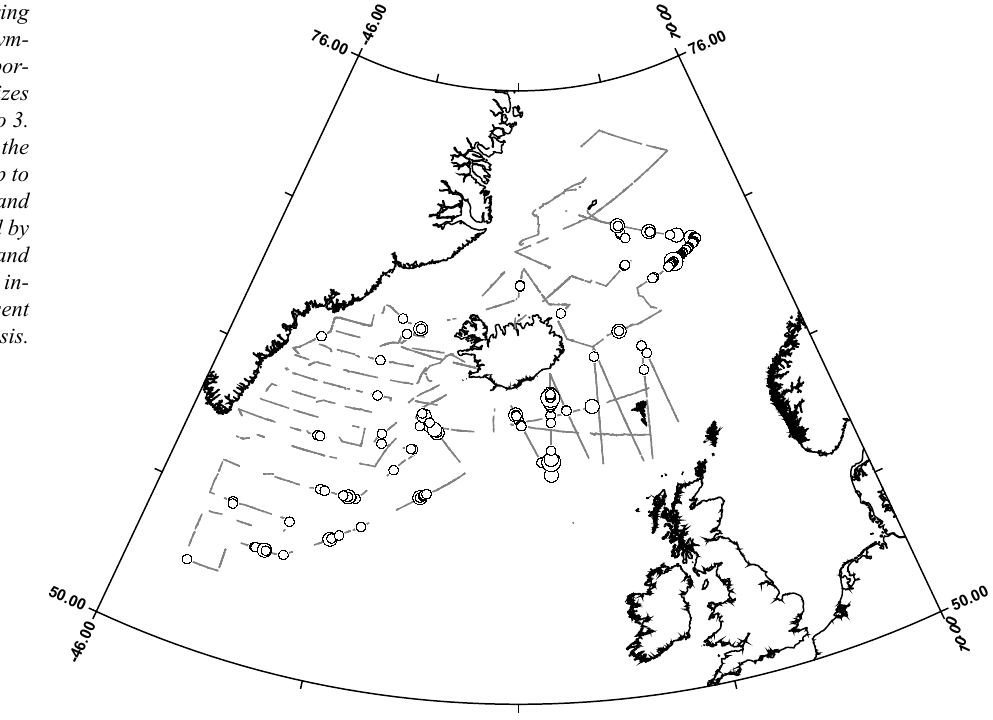
Fig. 1. Sightings of sperm whales during the 2001 NASS. Sym - bol size is propor - tional to group sizes ranging from 1 to 3. The tracks around the Faroe Islands up to South-East Iceland were covered by Faroese vessels and could not be in - cluded in the present